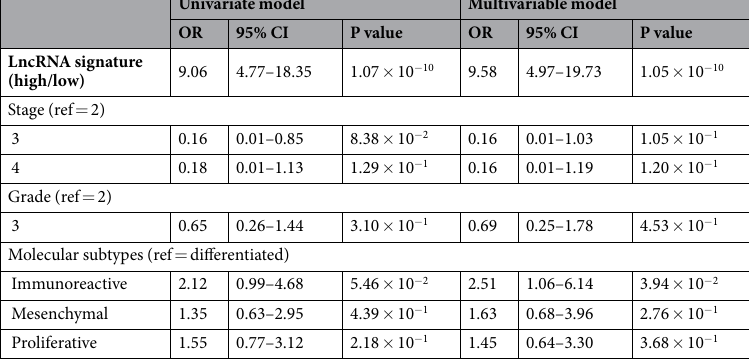
Table 2. Univariable and multivariable logistic regression models in the training